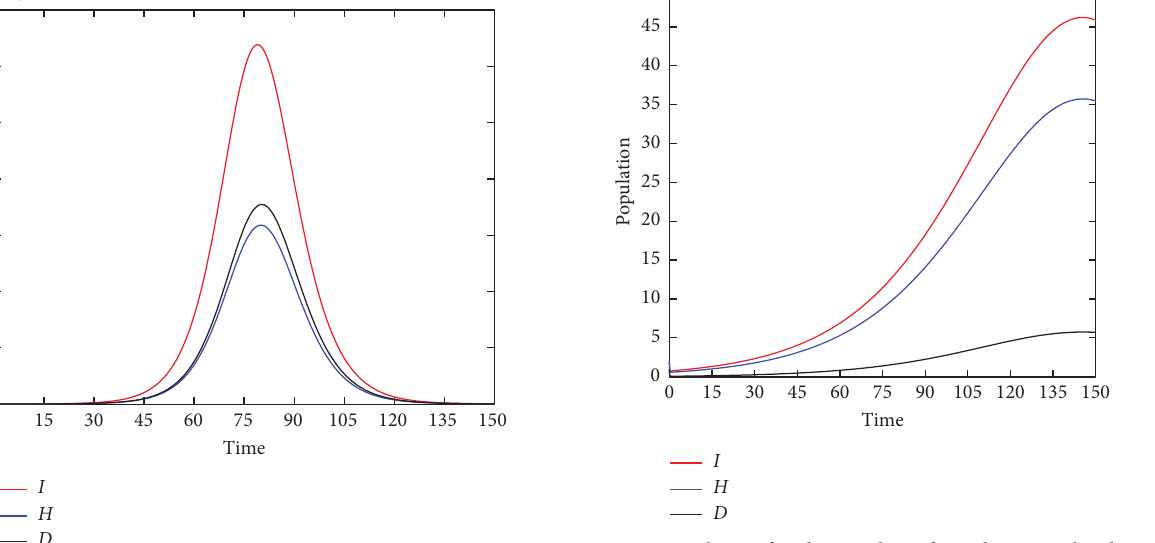
Figure 5: Simulation for the number of Dead, Hospitalized, and Symptomatic Infected with 90% of population obeying the rule of social